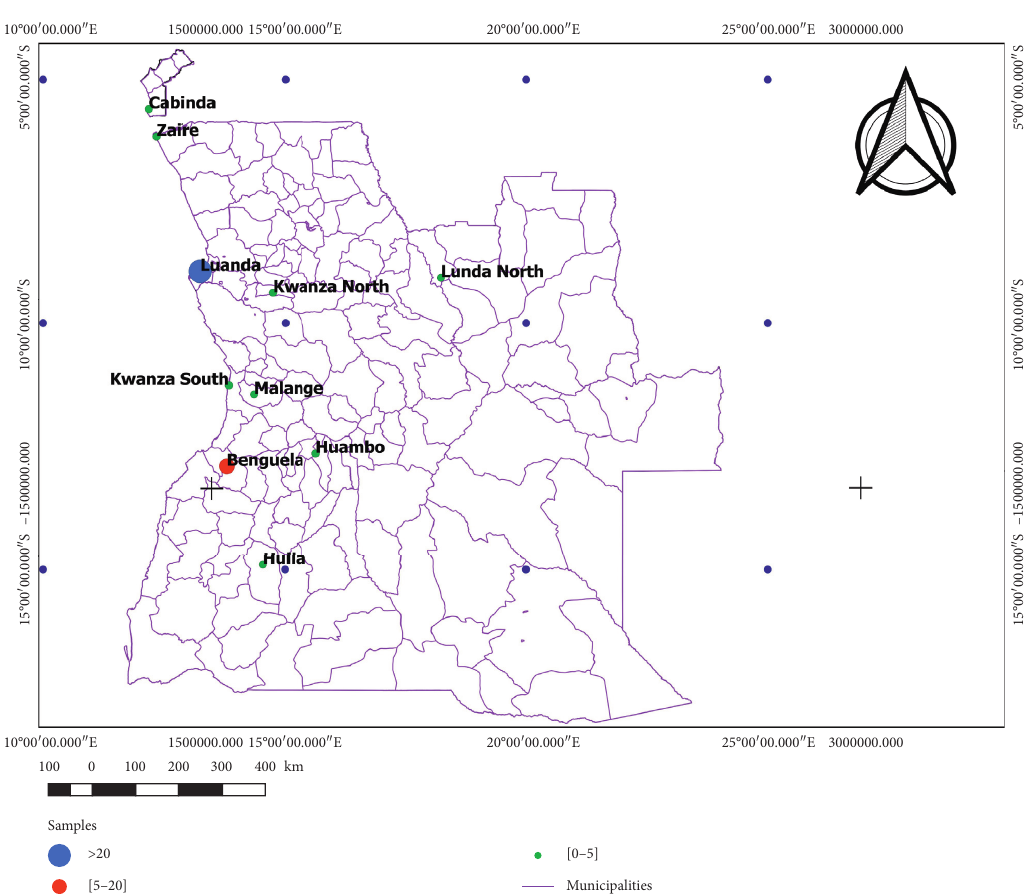
Figure 1: Study area with Angola sampling location cities (Benguela, Cabinda, Huambo, Luanda, and Malanje) and provinces (Hu´ıla, Kwanza Sul, Kwanza Norte, Lunda Norte, and